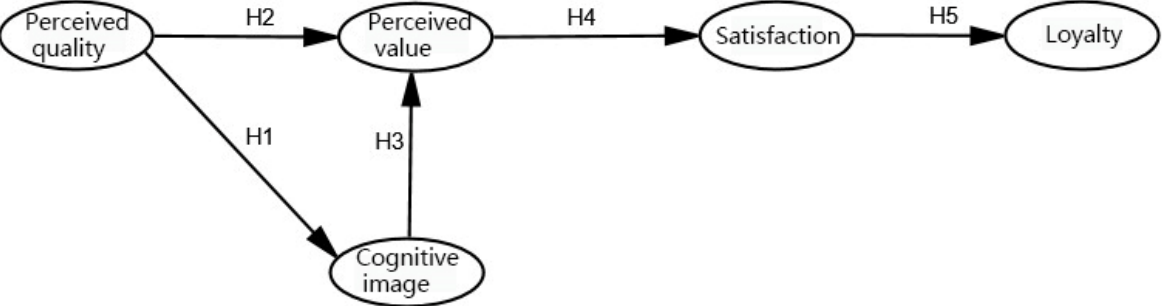
Figure 2. Cultural experience satisfaction